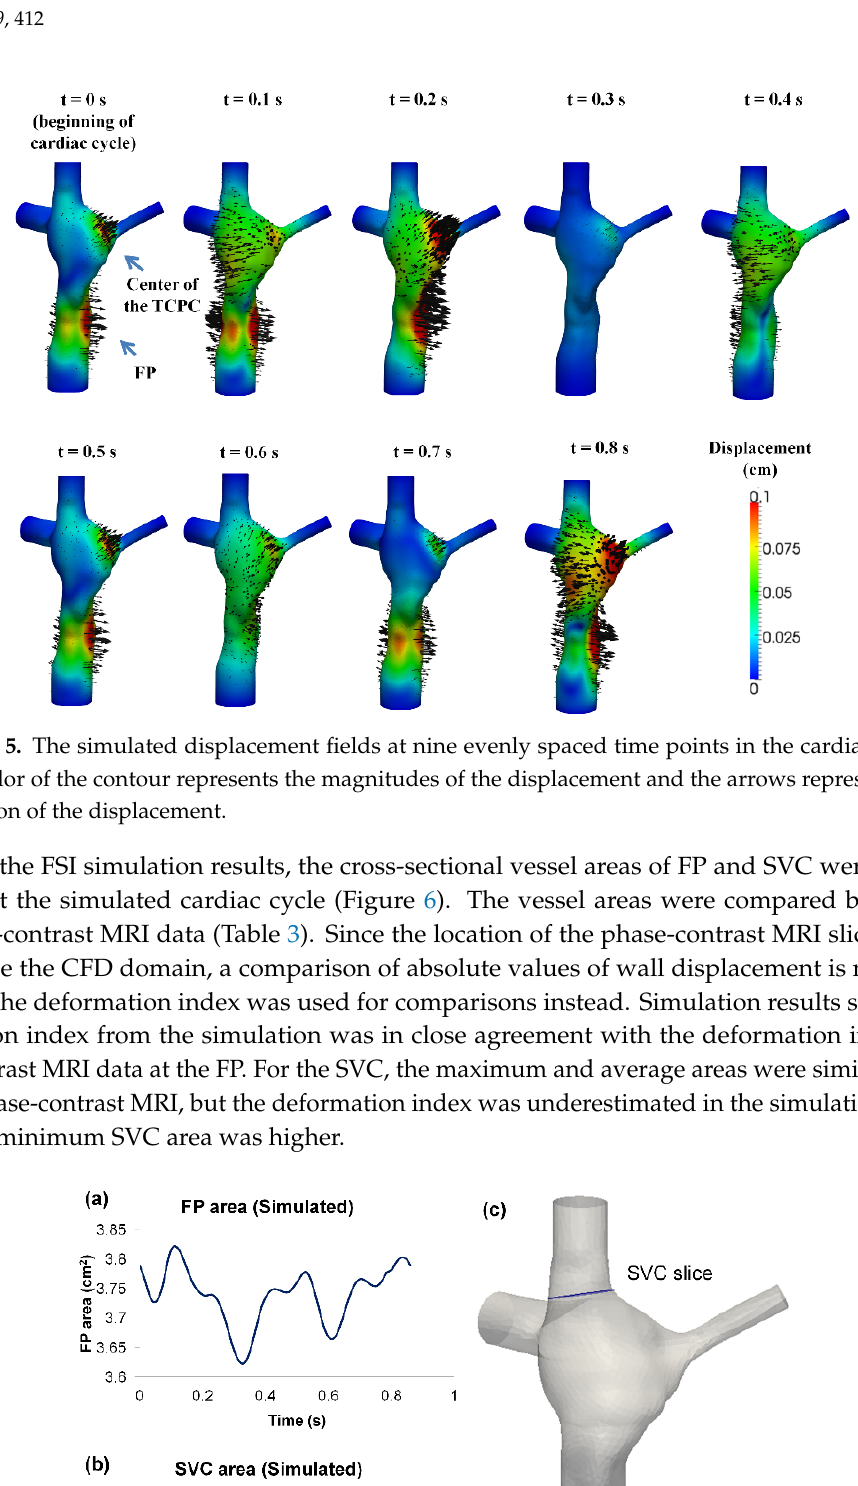
Figure 6. Simulated vessel area waveform of: ( a ) FP and ( b ) SVC from the FSI simulation results. The “FP slice” and “SVC slice” in ( c ) represent the location of where the FP and SVC area waveforms were extracted. FP: Fontan pathway, SVC: superior vena cava.